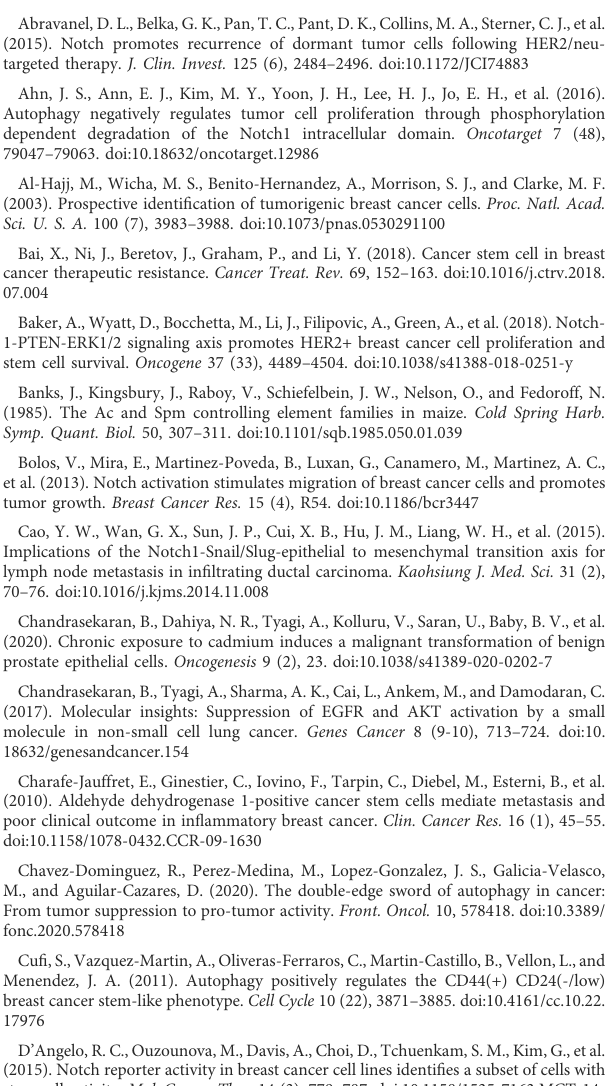
plotted on the X axis, and the False Discovery Rate (FDR) signi fi cance is plotted on the Y axis ( − log10 scale). The grey dots represent no signi fi cant change, reddots represent logFC of > 1.5and FDR < 0.05and blue represent logFC < − 1.5 and FDR < 0.05. SUPPLEMENTARY FIGURE S2 KEGG pathway for differential expressed genes based on RNA-seq data for ALDH − treatment vs. control, ALDH + treatment vs. control and ALDH + against ALDH − . Each bubble ’ s color and size correspond to the amount of differentially expressed mRNAs that are enriched in a certain GO keyword or KEGG pathway, respectively. The cutoff utilized to choose KEGG keywords was p < 0.05. SUPPLEMENTARY FIGURE S3 Representative bright fi eld and immuno fl uorescent images of Notch1-NICD (active form of Notch1) expression in vehicle and ASR490-treated second and third generation mammospheres of ALDH − , ALDH + and CD44 + /CD24 − cells. SUPPLEMENTARY FIGURE S4 Gene Ontology analysis for differential expressed genes based on RNA-seq data for ALDH − treatment vs. control, and ALDH + treatment vs.